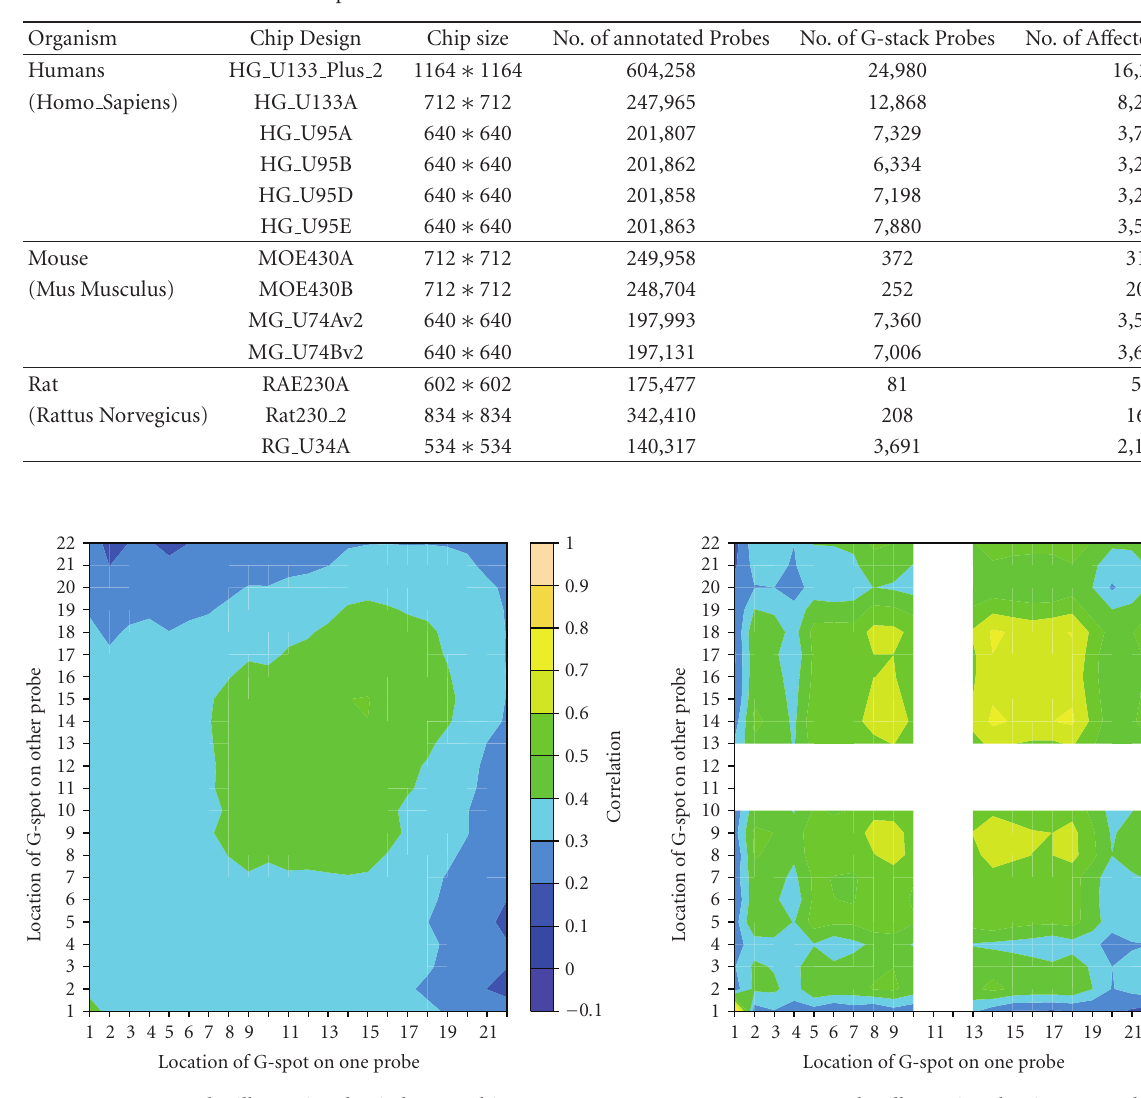
Figure 2: Contour plot illustrating that in mouse chip MOE430B, the average correlation coe ffi cient values changes according to the position of G-stack (with four Gs only) for a group of